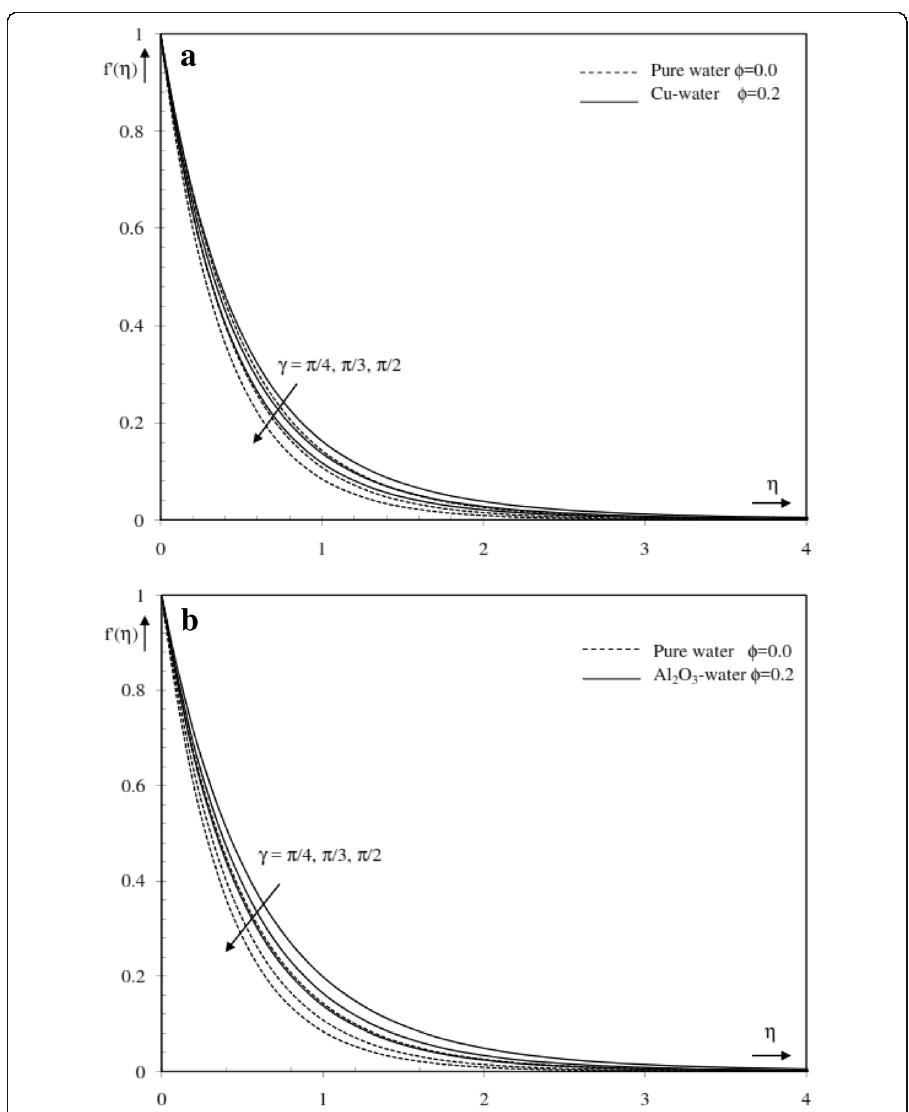
Fig. 17 Effects of γ on velocity distribution f ′ ( η ) for M = 5, S = f w = 0.1, and λ = A = B = 0.5 for a Cu-water and b Al 2 O 3